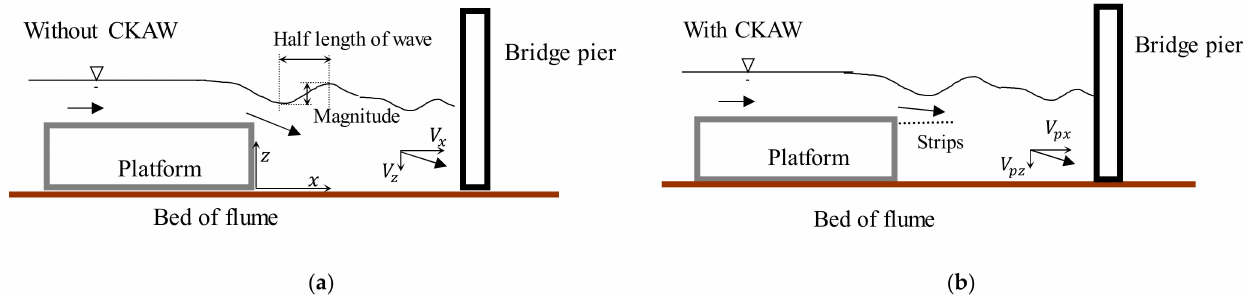
Figure 5. Illustration of CKAW’s protective effect. ( a ) Without the installation of CKAW; ( b ) With the installation of CKAW.